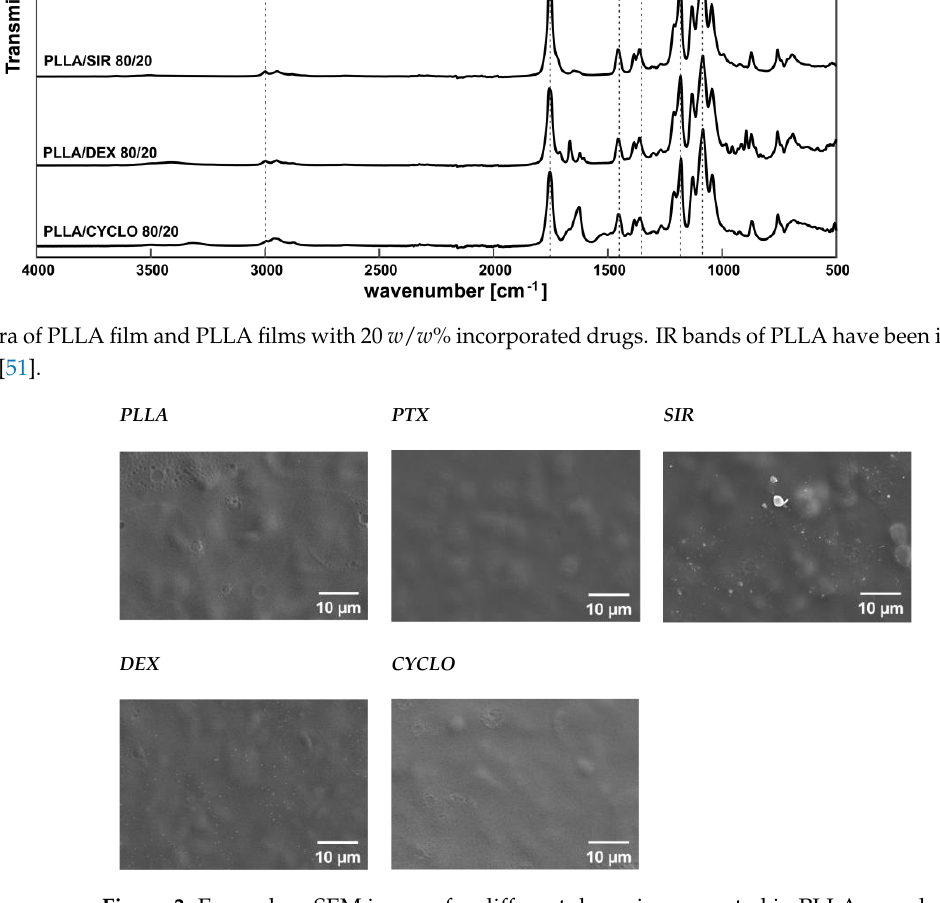
Figure 4. Exemplary Raman mapping images for different drugs incorporated in PLLA (PLLA/drug 20/80 w / w %). For CYCLO no distinct Raman signal could be detected. 3.3. Influence of Drug Incorporation on Surface Hydrophilicity Figure 5 gives an overview on the contact angles for the polymer films addressed in this study. Exemplary images of the drops can be found in the Supplementary Figure S6. Compared to PLLA reference film, drug incorporation showed to have no effect on the surface wettability as all contact angles are in a range of 70 – 80 °. Furthermore, surface free energy (SFE) calculated from contact angle data acquired from water and diiodo- methane have been calculated. As can be seen, incorporation of the chosen drugs did not result in observable changes in SFE.